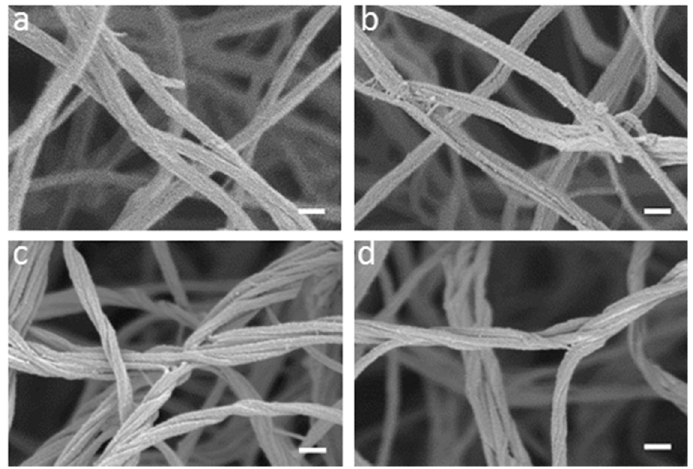
Figure 4. Fiber layout within hydrogels. SEM images of ( a , b ) fibrin and ( c , d ) collagen gels acquired at magnifications of 80–120 kX show the morphological features of the fibers. The collagen fibers exhibit characteristic bundling, whereas the fibrin fibers are formed more individually. The scale bars correspond to 200